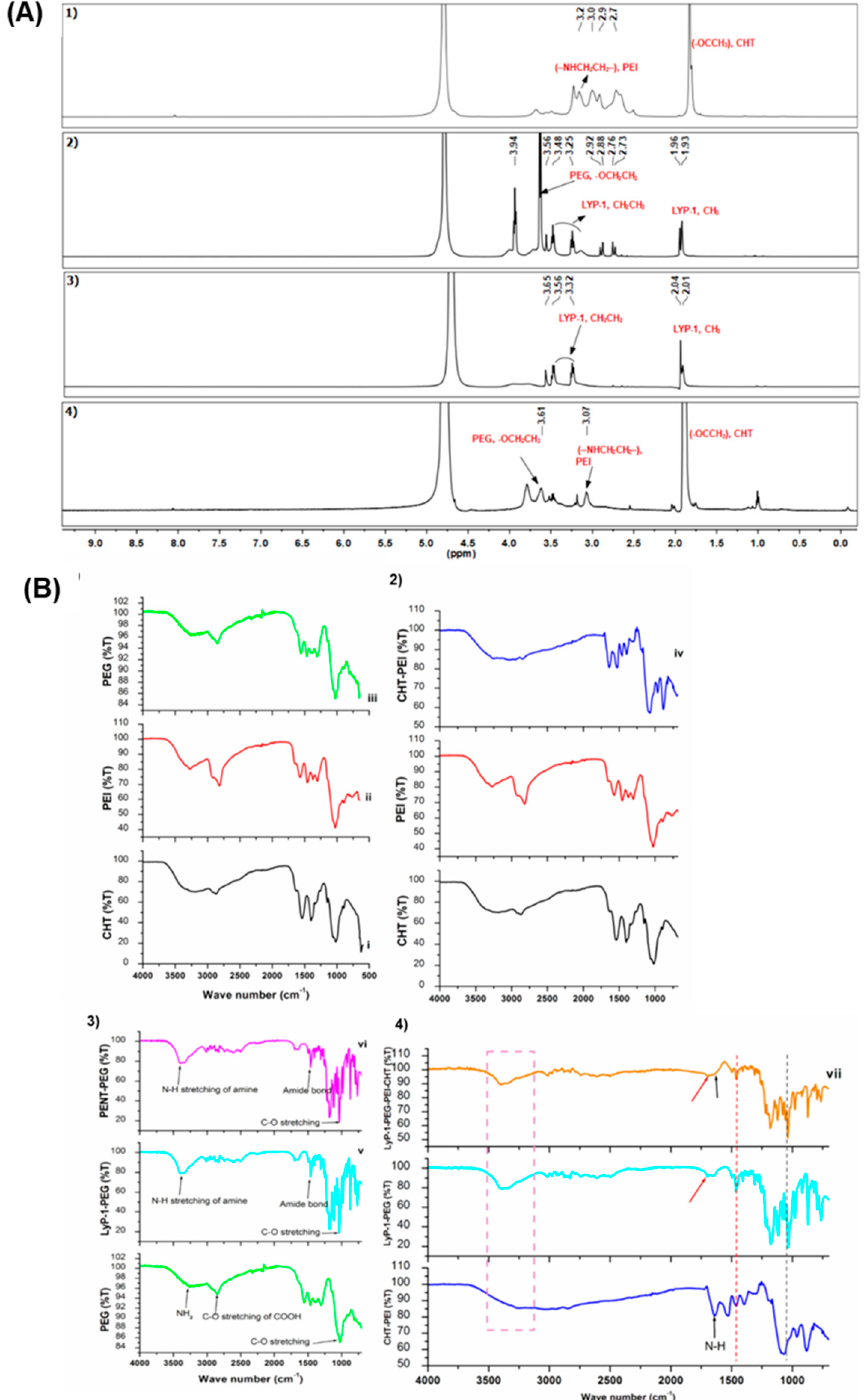
Figure 2. Structural and functional modification of LyP-1-functionalized nanosystem. ( A ) 1 H NMR profile of the co-polymers in D 2 O:CH 3 COOD (5:1): ( 1 ) native chitosan-based conjugate, ( 2 ) linear LyP-1-conjugate, ( 3 ) cyclic LyP-1-conjugate, and ( 4 ) cyclic LyP-1-functionalized conjugate. ( B ) FTIR spectra of native and LyP-1 modified nanosystem. ( 1 ) Pure polymers including CHT, PEI and PEG, ( 2 ) spectra showing peaks for CHT, PEI and CHT-g-PEI nano-conjugate, ( 3 ) spectra of PEG and LyP-1-PEG-NH 2 conjugates, and ( 4 ) spectra of CHT-PEI, LyP-1-PEG-NH 2 and LyP-1-PEG-PEI-CHT nano-conjugates.